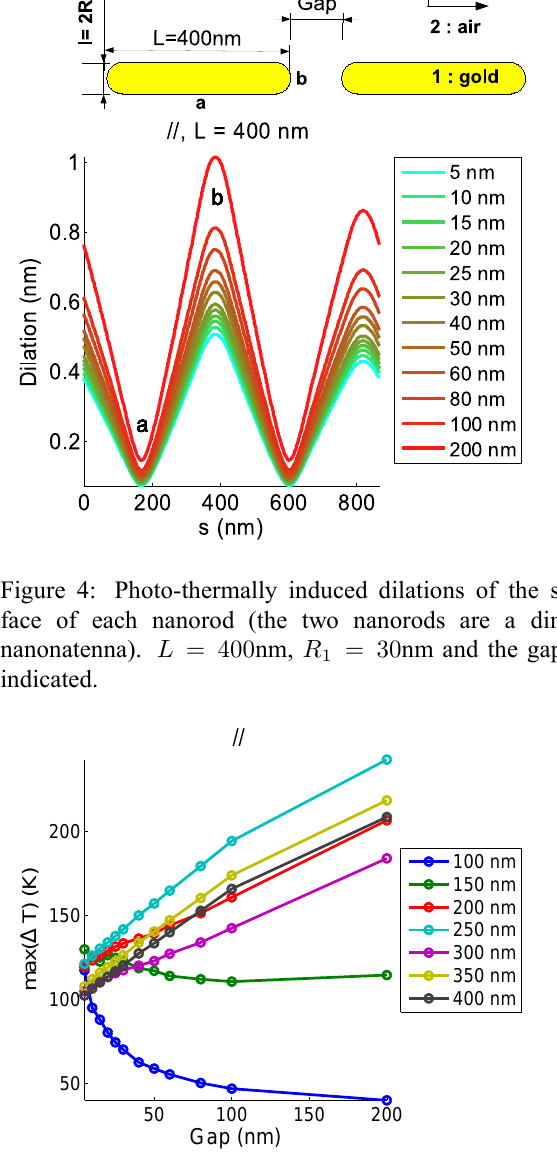
Figure 5: Temperature elevation as a function of the initial gap (in nm).